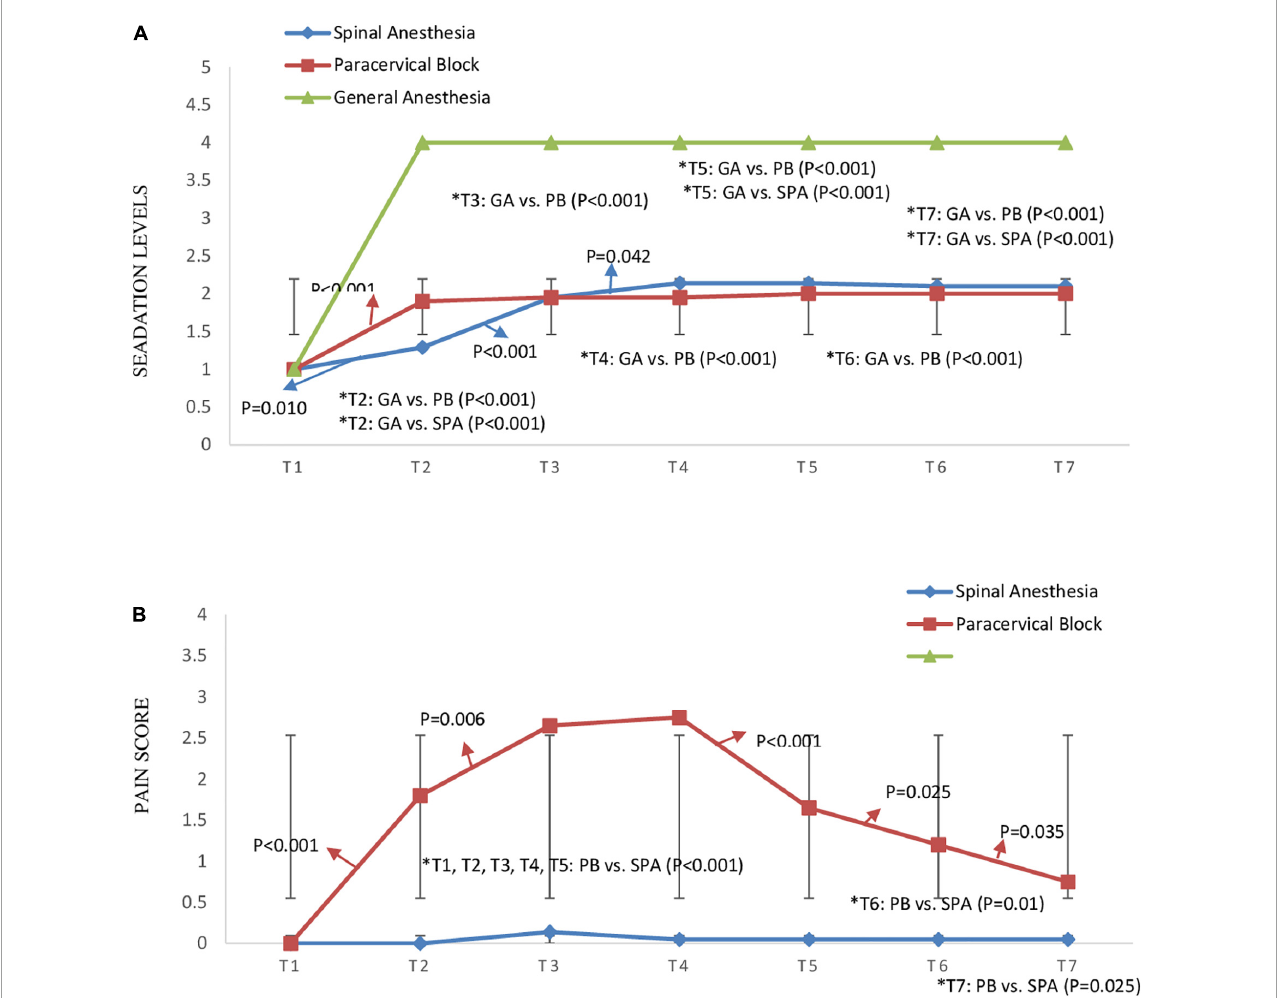
FIGURE4 Time trend changes in panel (A) sedation levels based on “Ramsay Sedation Scale” between three groups of study and (B) pain score based on visual analog scale (VAS) between spinal anesthesia and paracervical block groups (pain score was not measured for general anesthesia). Time trends as follows; T1: pre-anesthesia, T2: during-anesthesia, T3: during-tenaculum, T4: during-cervical dilation, T5: during-hysteroscopy, T6: during-biopsy, and T7: during-hysteroscopy removal. The P -value within group differences are indicated by arrows and between groups by ∗ . SPA, spinal anesthesia; PB, paracervical block; GA, general